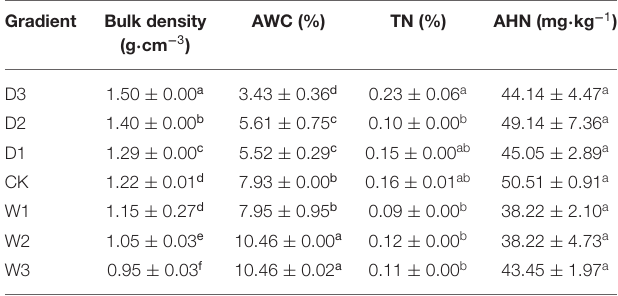
TABLE 1 | The mean values of soil physical properties of the precipitation treatments from July to August.